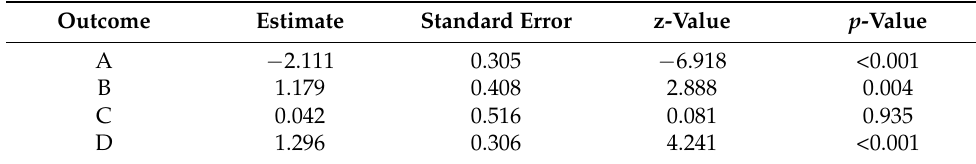
Table 2. Results of the GLMM testing the effect of outcome on likelihood of expressing stress-related behaviors within 3 min after